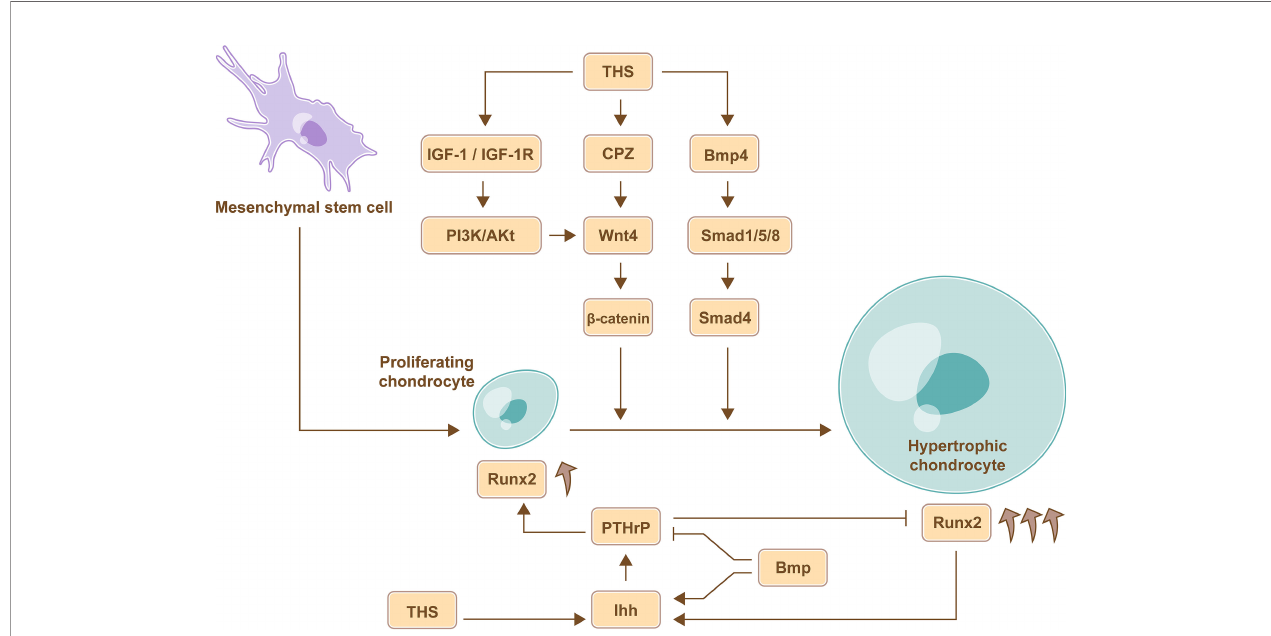
FIGURE 1 | TH-mediate regulation of chondrocyte proliferation and differentiation. THs promote the differentiation of chondrocyte via Wnt signaling pathway, BMP signaling pathways, and IGF-1 signaling pathway. Furthermore, the expression of Ihh in pre-hypertrophic and hypertrophic chondrocytes induces the expression of PTHrP, which promotes chondrocyte proliferation and inhibits chondrocyte maturation through a negative feedback loop, and the site of hypertrophic chondrocytes determines the length of the bone, therefore, THs regulate the length of long bone by Ihh-PTHrP signaling pathway. Furthermore, BMP can increase the expression of Ihh and abrogates the partial inhibition of the maturation effects of PTHrP to regulate chondrocyte proliferation and maturation, and the increased expression of Runx2 in mature and differentiated chondrocytes is bene fi cial for stimulating chondrocyte proliferation mediated by